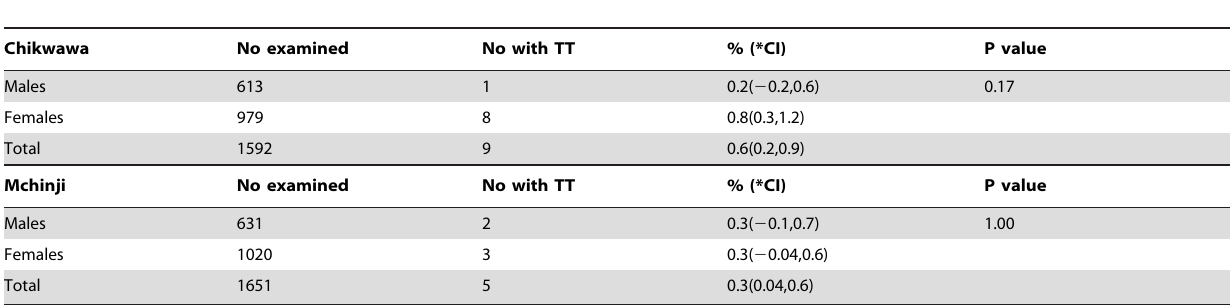
Table 5. Prevalence of Trachoma Trichiasis (TT) by sex in Chikwawa and Mchinji districts.